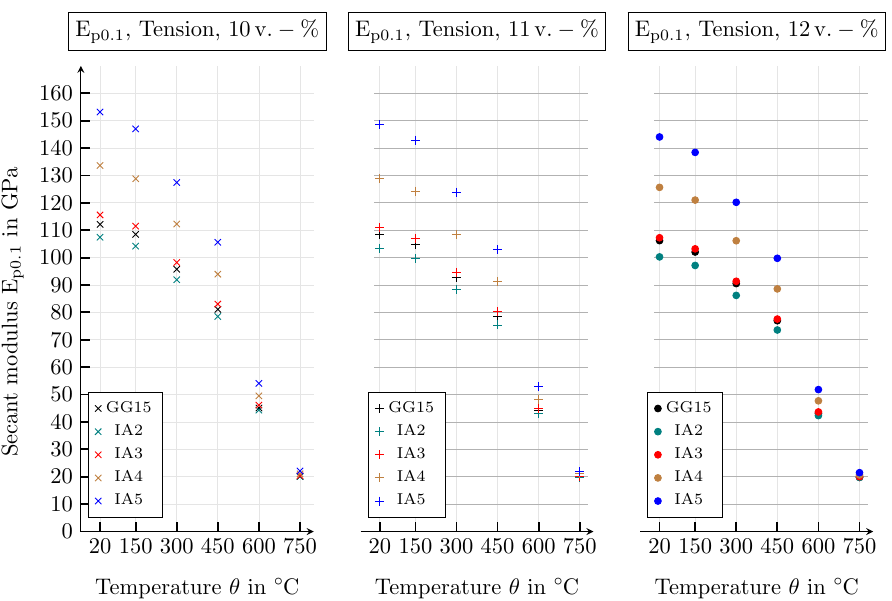
Figure 22. Secant moduli of all graphite classes with graphite flake volume fractions of 10, 11 and 12v. %, evaluated for the temperatures 20, 150, 300, 450, 600 and 750°C, at a tensile strain of 0.1%. −